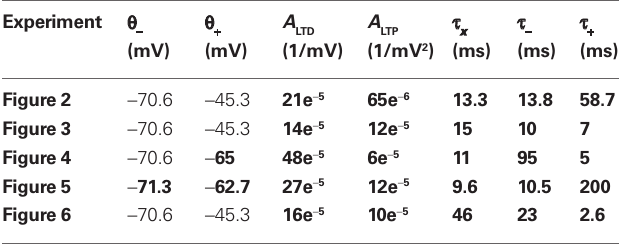
Table 2 | Parameters of the plasticity model fitted to different experiments.